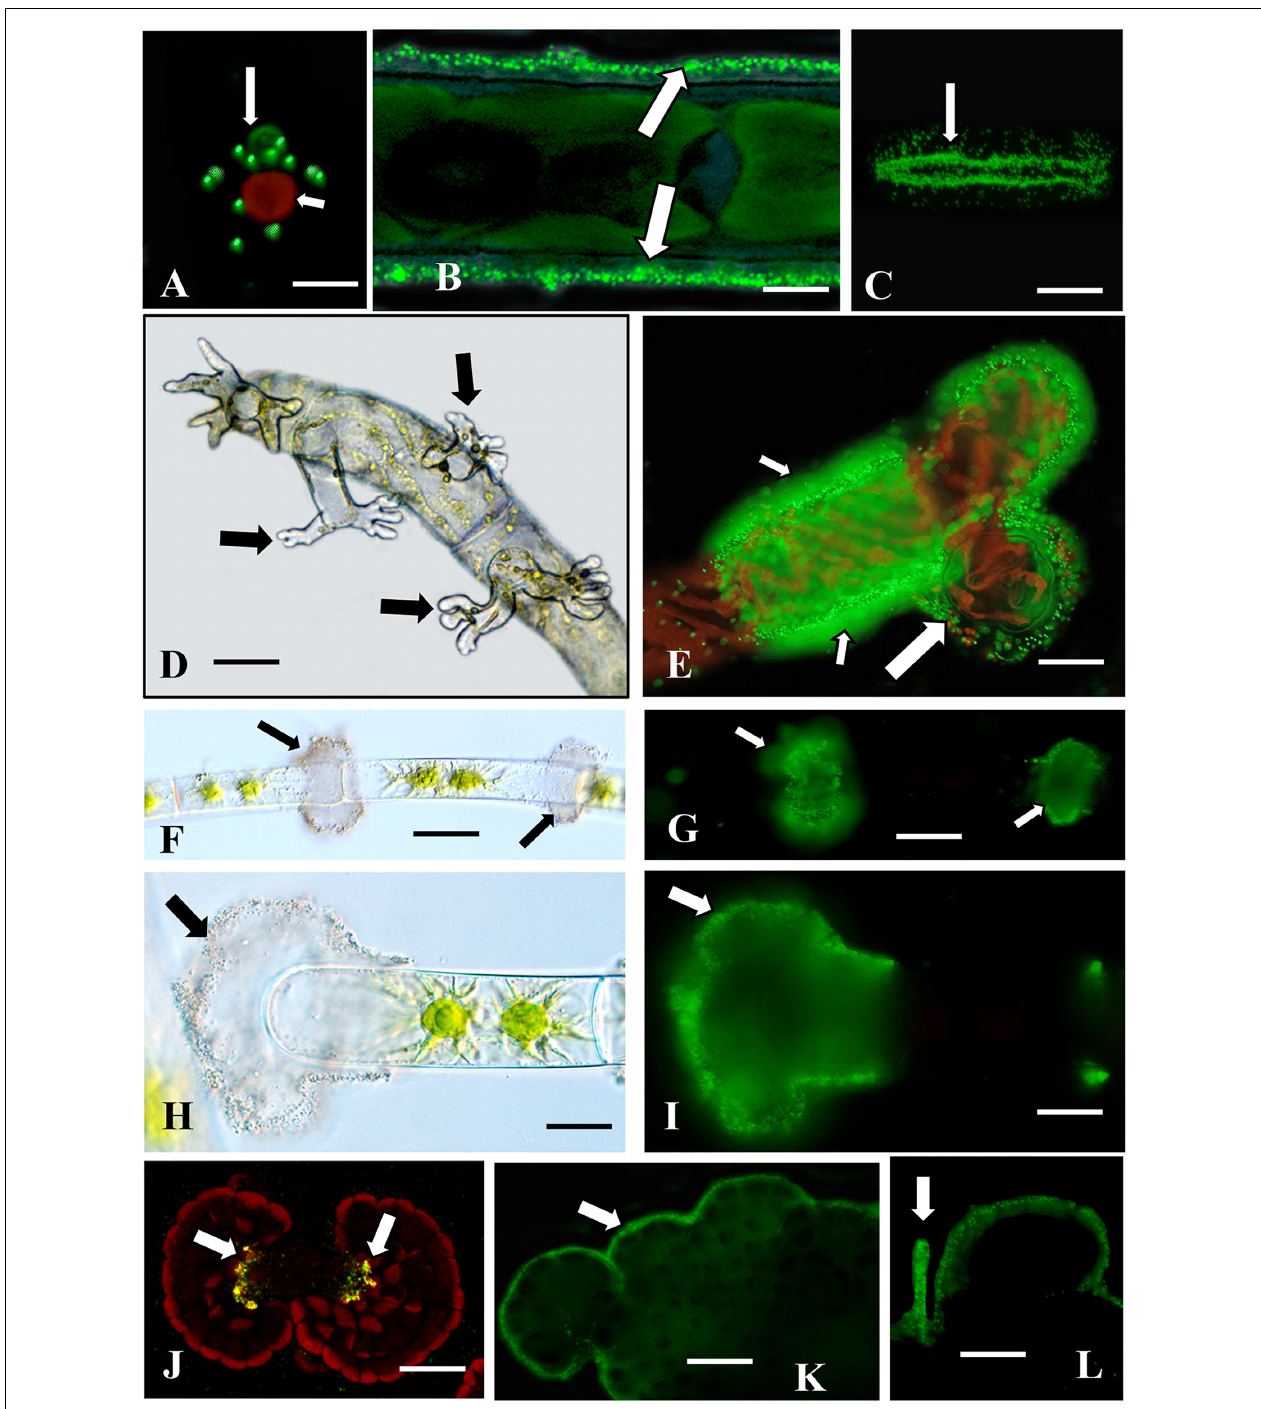
FIGURE 1 | Adhesion zones identified with fluorescent beads. (A) Chlorokybus (small arrow) adheres to glass or plastic substrates. Fluorescent beads label the zone adjacent to the cell attachment site (large arrow). Bar 5.2 µ m. (B) Bead labeling of the cell wall surface of Penium (arrows) after EPS was washed from the cell surface. Bar 45.3 µ m. (C) Bead labeling of the adhesive “footprint” (arrow) that remains on the substrate after Penium is washed from substrate surface. Bar 45.3 µ m. (D) Rhizoids (arrows) emerge from live cells immediately adjacent to the wound zone in a wounded Spirogyra filament. Bar 21.1 µ m. (E) Bead labeling of a sheath that is external to the cell wall of growing rhizoids (large arrow). Note that the surface of the rhizoid producing cell also labels (small arrows). (F,G) Labeled “clouds” of beads are found at the cross-wall areas of planktonic Zygnema filaments (arrows). (H,I) Bead labeling at the sheath surrounding the cell at a fragmentations site (arrow). (J) Bead labeling of the center thallus zones of Coleochaete (arrows). (K) The beads also label the thallus margins ( K , arrow) and the hairs emerging from the dorsal side of the thallus ( L , arrow). Bars ( F–L ) 5.2 µ m.